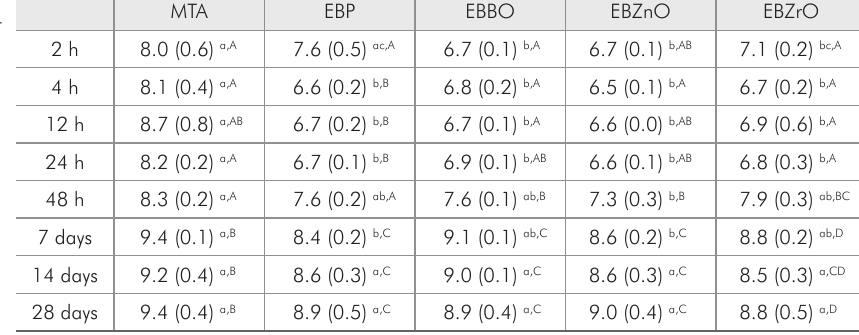
Table 2 - Mean and standard deviation of pH values at different time intervals.